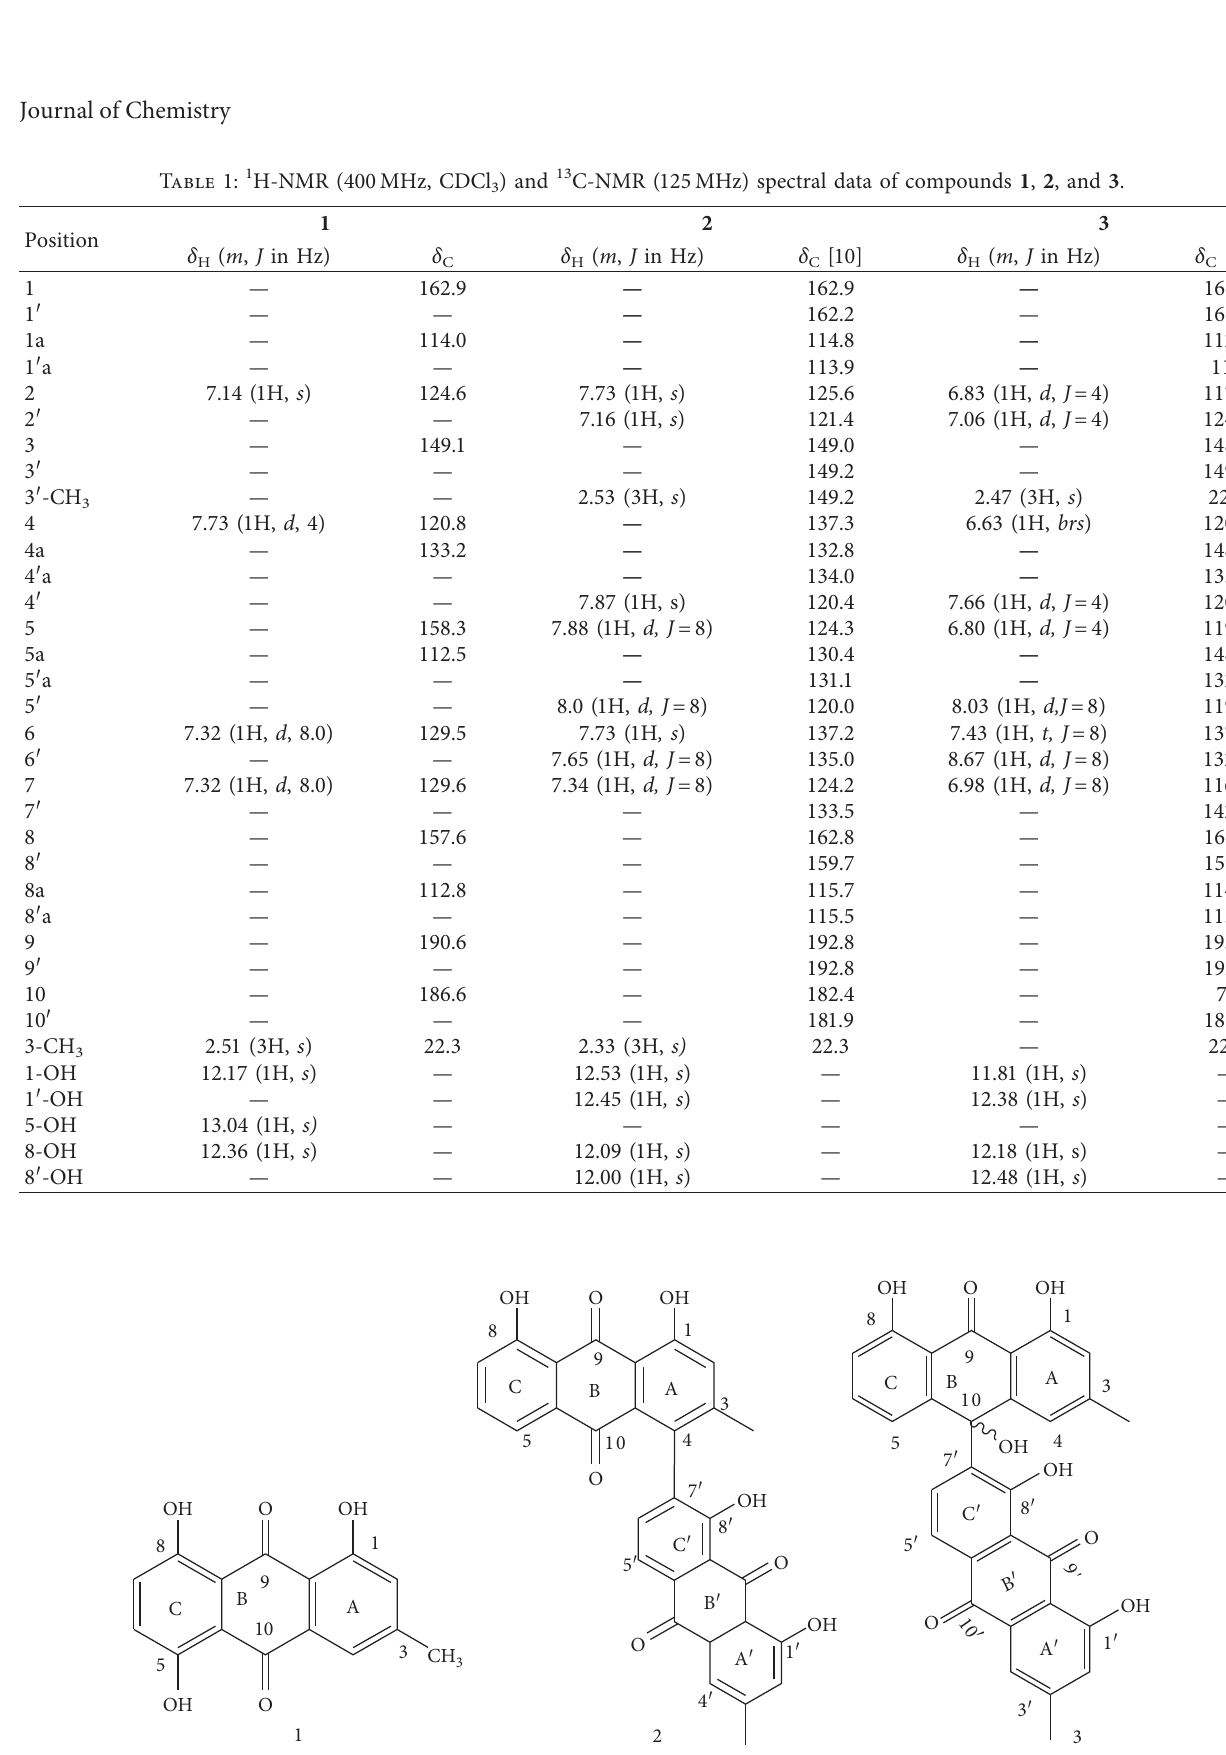
Figure 1: The structures of helminthosporin ( 1 ), asphodeline ( 2 ), and 10-hydroxy-10-(chrysophanol-7 ′ -yl)-chrysophanol anthrone ( 3 ) isolated from root of K.